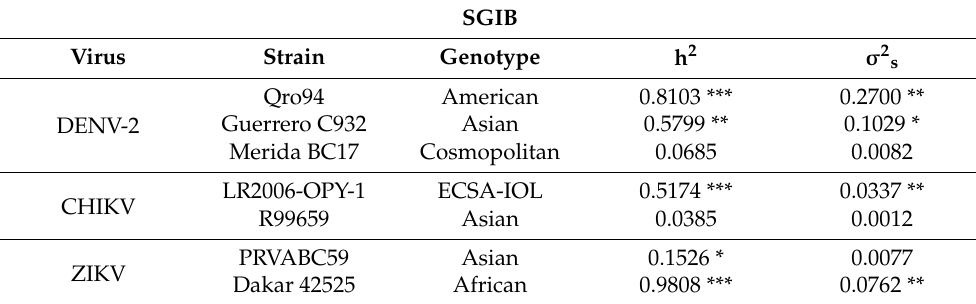
Table 2. Quantitative genetic analysis of salivary gland infection barrier in Aedes aegypti . Each analysis corresponds to one of the seven virus strains tested for log 10 (PFU)/salivary gland. We used PROC MIXED in SAS to obtain restricted maximum likelihood (REML) to estimate quantitative genetic parameters. The greater the variance in sire means, the larger the heritability. SGIB Virus Strain